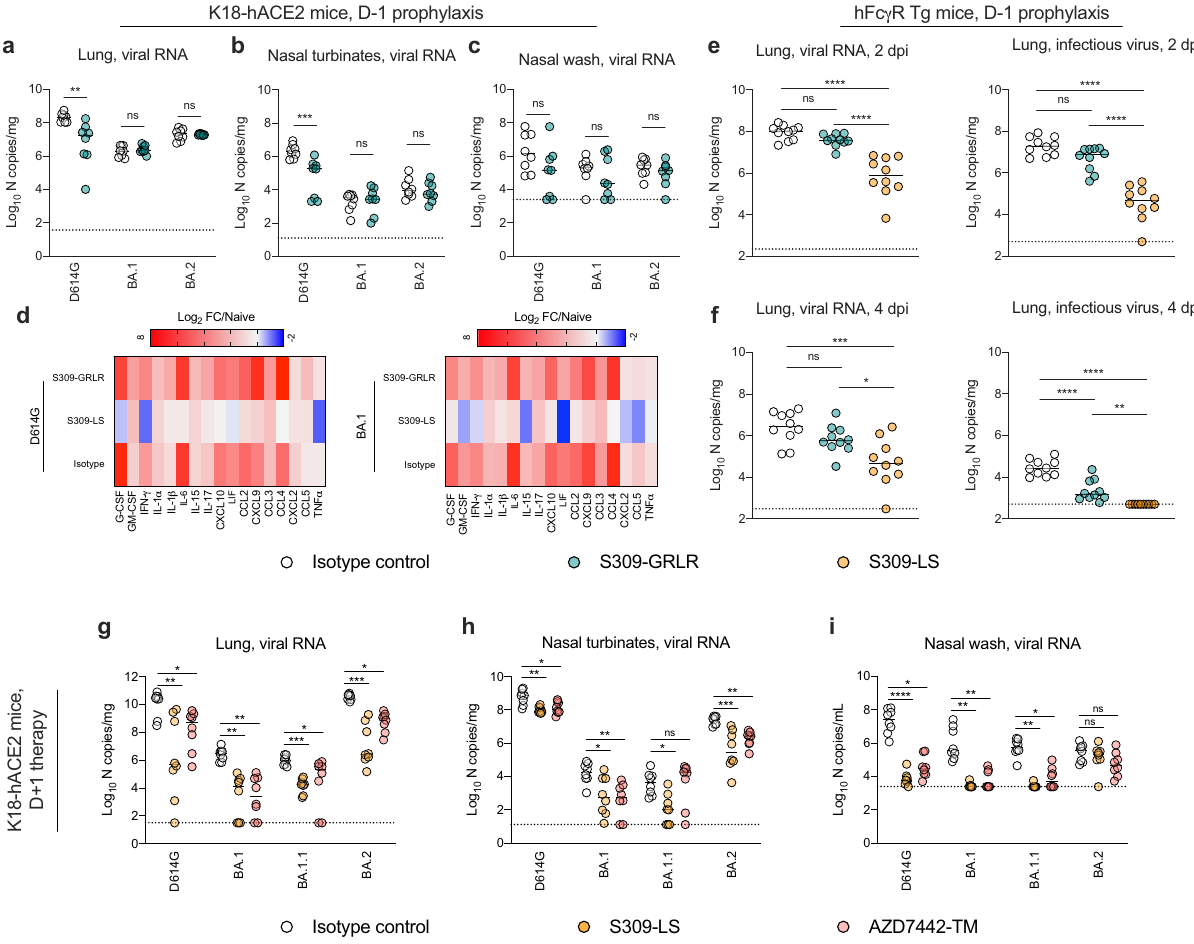
Fig. 4 Fc-effector functions and mAb-mediated protection. a – d Eight-week-old female K18-hACE2 mice or ( e , f ) 12-week-old male hFc γ R Tg mice received a single 10 mg/kg or 3 mg/kg dose respectively, of isotype control, S309-LS or S309-GRLR mAb by intraperitoneal injection one day before intranasal inoculation with 10 3 FFU of D614G, BA.1, or BA.2 ( a - c ) or 10 5 FFU of Beta (B.1.351) ( e , f ). Tissues were collected at 2 (B.1.351), 4 (B.1.351), 6 (BA.2), or 7 (D614G and BA.1) dpi. Viral RNA levels in the lungs ( a , e , f ), nasal turbinates ( b ), and nasal washes ( c ) were determined by RT-qPCR, and infectious virus in the lungs ( e , f ) was measured by plaque assay. a - c , e , f lines indicate median ± SEM.; a - c and e , f n = 8 and 10 mice per group, respectively; two experiments; a - c Two-tailed Mann-Whitney test between isotype and mAb treatment; ns, not signi fi cant; ** P < 0.01, *** P < 0.001 e , f one- way ANOVA with Tukey ’ s multiple comparisons test; ns, not signi fi cant; * P < 0.05, ** P < 0.01, *** P < 0.001, **** P < 0.0001). d Heat map of cytokine and chemokine protein expression levels in lung homogenates from the indicated groups. Data are presented as log 2 -transformed fold-change over naive mice. Blue, reduction; red, increase. S309-LS data in Fig. 2i is included for comparison. g – i Eight-week-old female K18-hACE2 mice were inoculated with 10 3 FFU of the indicated SARS-CoV-2 strain by intranasal administration one day before receiving a single 30 mg/kg dose of S309-LS or AZD7442-TM mAb by intraperitoneal injection. Tissues were collected at 6 (BA.2) or 7 (all other strains) dpi. Viral RNA levels in the lungs ( g ), nasal turbinates ( h ), and nasal washes ( i ) were determined by RT - qPCR. g – i lines indicate median ± SEM; n = 8 mice per group; two experiments; Kruskal-Wallis test between isotype control and each mAb treatment with Dunn ’ s multiple comparisons test; ns, not signi fi cant; * P < 0.05, ** P < 0.01, *** P < 0.001, **** P < 0.0001. Source data are provided as a Source Data fi sterilized after passage through 0.22 μ m fi lters and stored at 4°C. VIR-7831 (clinical lead variant of S309-LS) was produced at WuXi Biologics. AZD8895 and AZD1061 mAbs were cloned into mammalian expression vectors and expressed as IgG1 constructs with the TM (L234F/L235E/P331S) Fc modi fi cation with or without a second YTE (M252Y/S254T/T256E) modi fi cation to extend half-life in humans. MAbs were expressed in 293 F cells after transfection with 293fectin (Thermo Fisher Scienti fi c) and isolated from supernatants by af fi nity chromatography using Protein A or Protein G columns (GE Healthcare). MAbs were eluted with 0.1 M glycine at low pH and dialyzed into PBS.